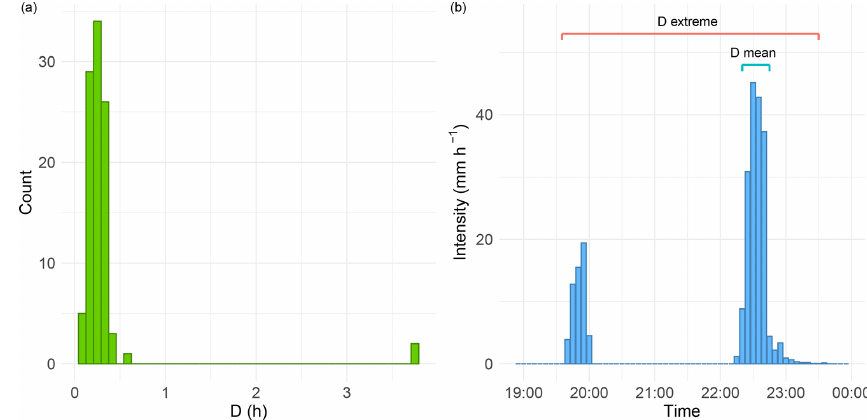
Figure 5. (a) Duration distribution histogram and (b) hyetograph of event 58. The histogram shows the presence of an extreme isolated from the mass of the distribution. This extreme ( D = 3 . 75h) is shown in the hyetograph and compared with the mean ( D = 0 . 32h).